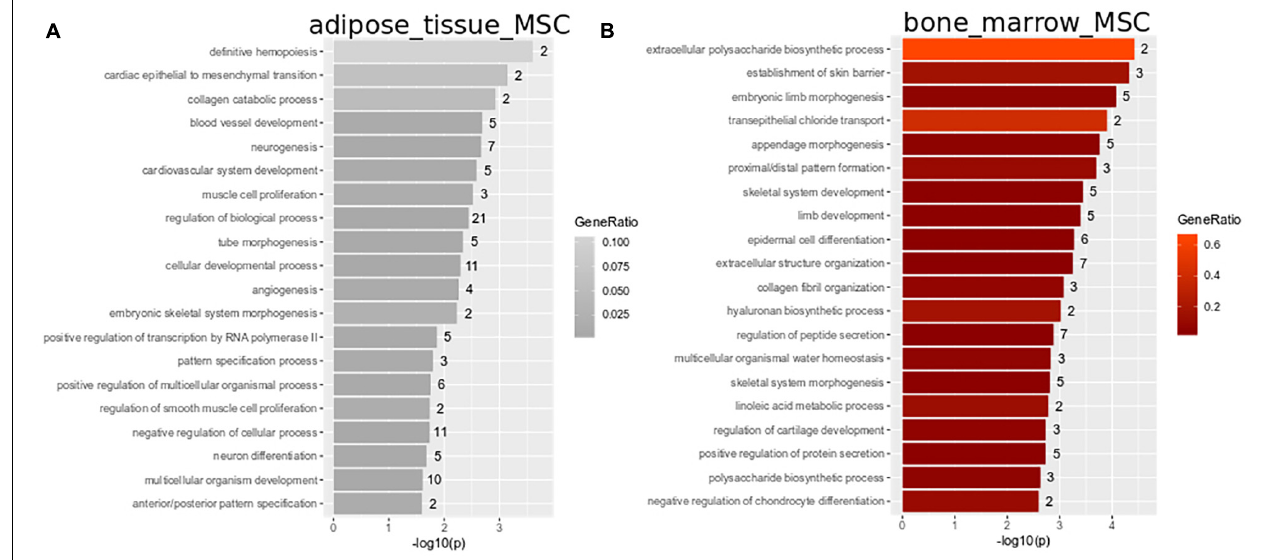
FIGURE 3 | Heterogeneity in adipose-tissue and bone-marrow-derived MSCs reflects tissue of origin. Subsets of genes exclusively expressed in adipose tissue-derived MSCs (29 genes in Figure 2A ) and bone-marrow-derived MSCs (130 genes in A ) were analyzed for over-representation of GO terms. (A) Most significantly over-represented GO terms in adipose tissue-derived MSCs include vascular, muscle and neuronal development which may be considered characteristic for adipose tissue. (B) Most significantly over-represented GO terms in bone-marrow-derived MSCs include skeletal system and limb development pointing at osteogenic